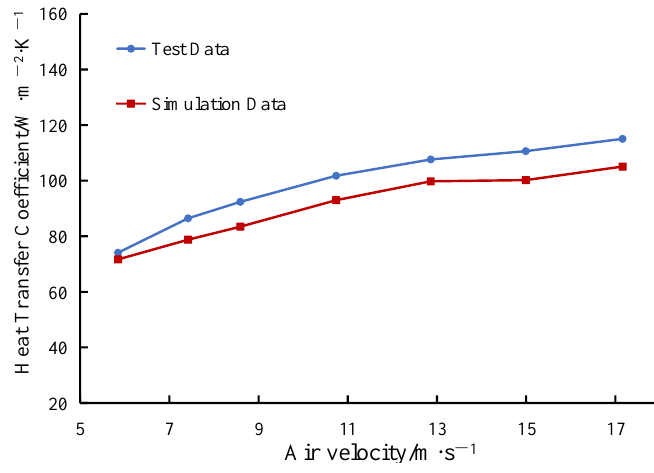
Figure 5. Comparison of simulation and test data.